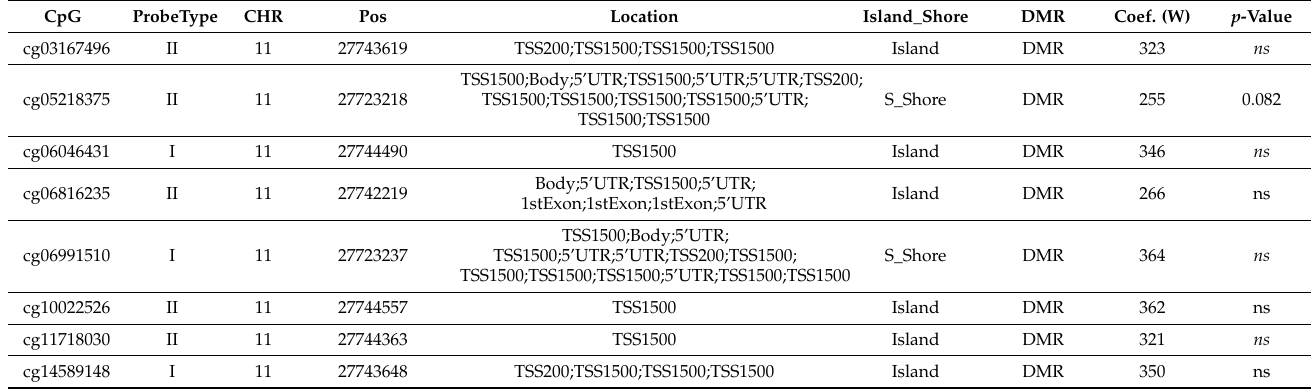
Table 5. Wilcoxon Rank Sum Exact Test Contrasting Individual BDNF Methylation M-values to Severity of Suicidal